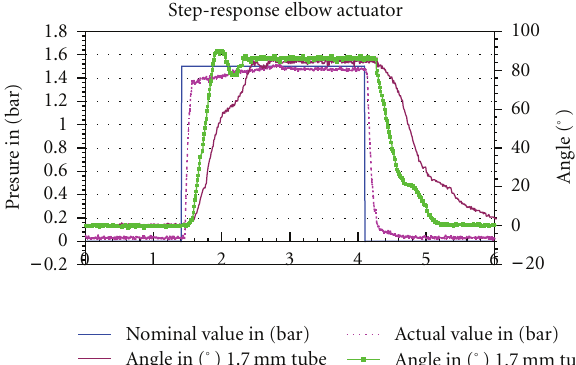
Figure 8: Step response of the elbow actuator with a 1.7 and a 2 . 7mm tube and 150kPa pressure.